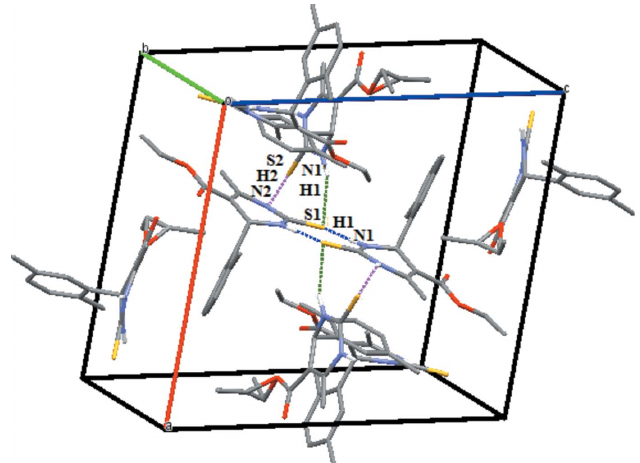
Figure 2 Unit-cell packing of the title compound, showing N2—H2 (cid:2)(cid:2)(cid:2) S2 and N1— H1 (cid:2)(cid:2)(cid:2) S1 interactions as dotted lines. H atoms not involved in hydrogen bonding have been excluded.